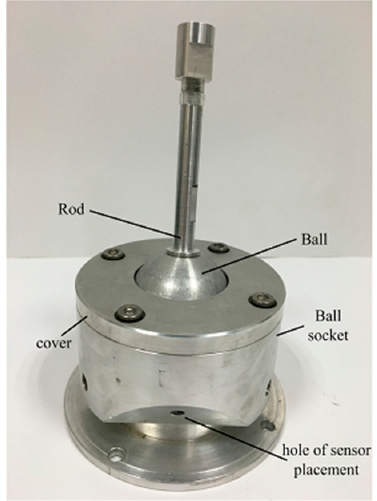
Figure 9. Image of the new intelligent ball joint prototype.